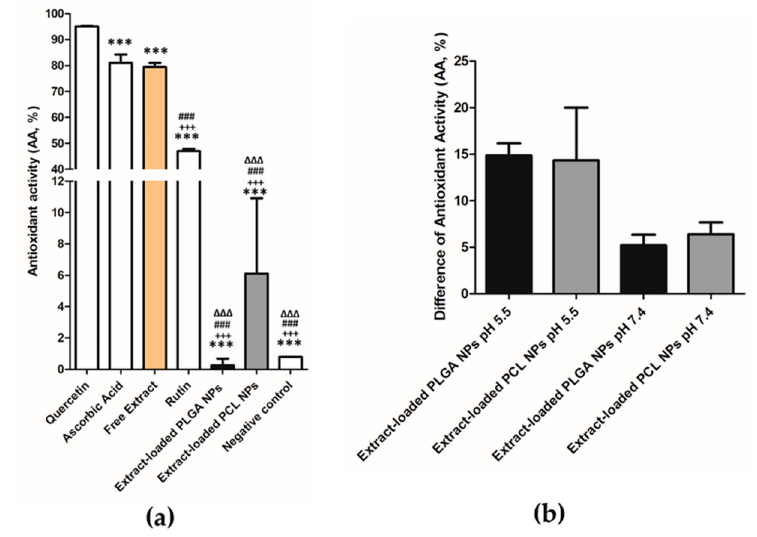
Figure 10. ( a ) AA of quercetin and ascorbic acid (positive controls), free extract, extract-loaded PLGA NPs, extract-loaded PCL NPs, (%, mean ± S.D.; n = 3, *** p < 0.001, when compared the quercetin with the other samples, +++ p < 0.001, when compared the ascorbic acid with the other samples, ### p < 0.001, when compared the free extract with the other samples and ∆∆∆ p < 0.001, when compared the rutin with the other samples), ( b ) Difference of AA in release medium when compared with respective extract-loaded NPs (%, mean ± S.D.; n = 3 ).